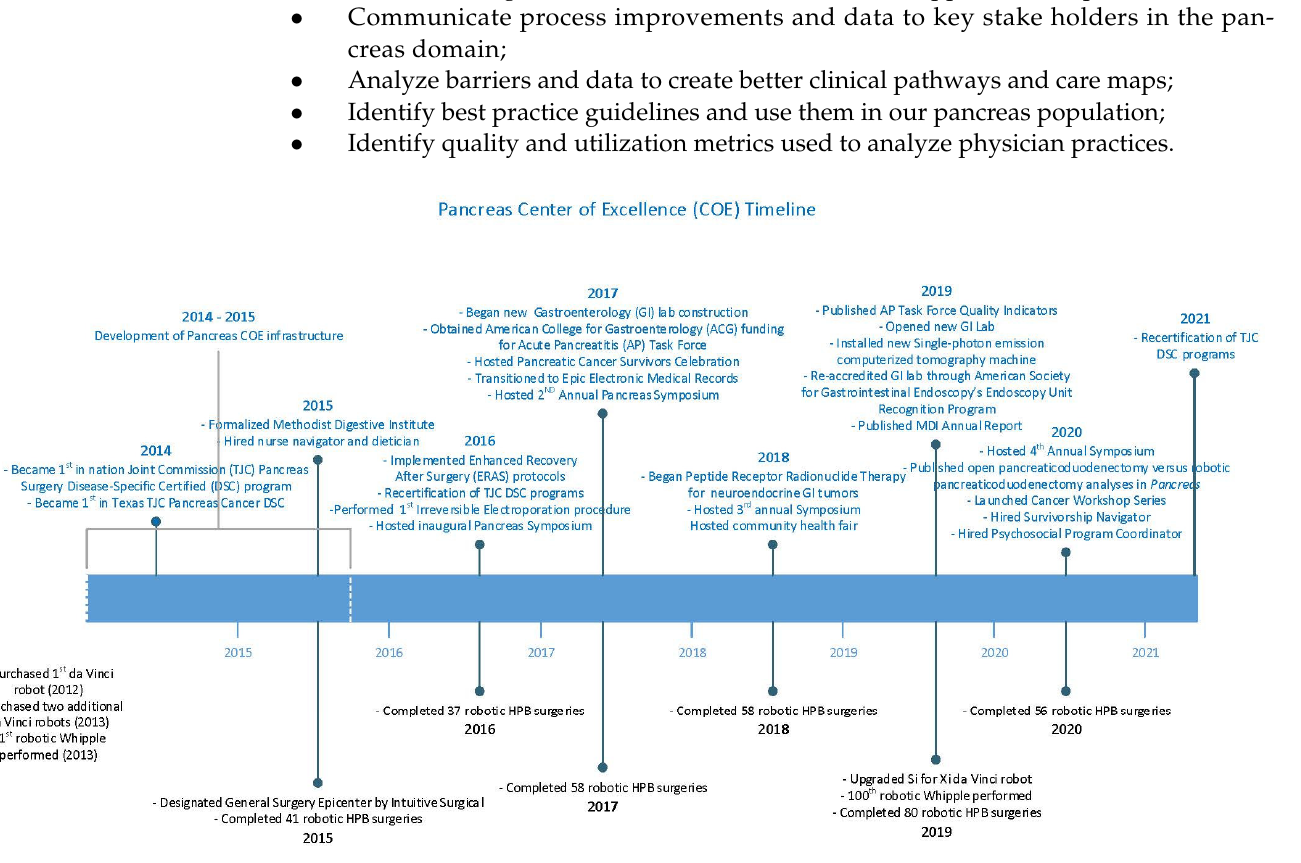
Figure 3. Pancreas CoE development timeline and major milestones .